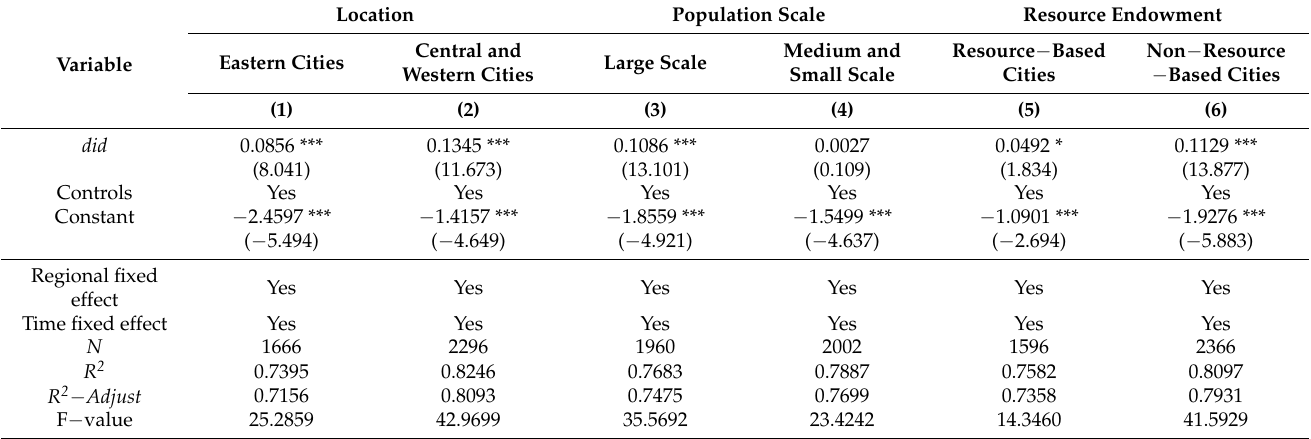
Table 8. Heterogeneity